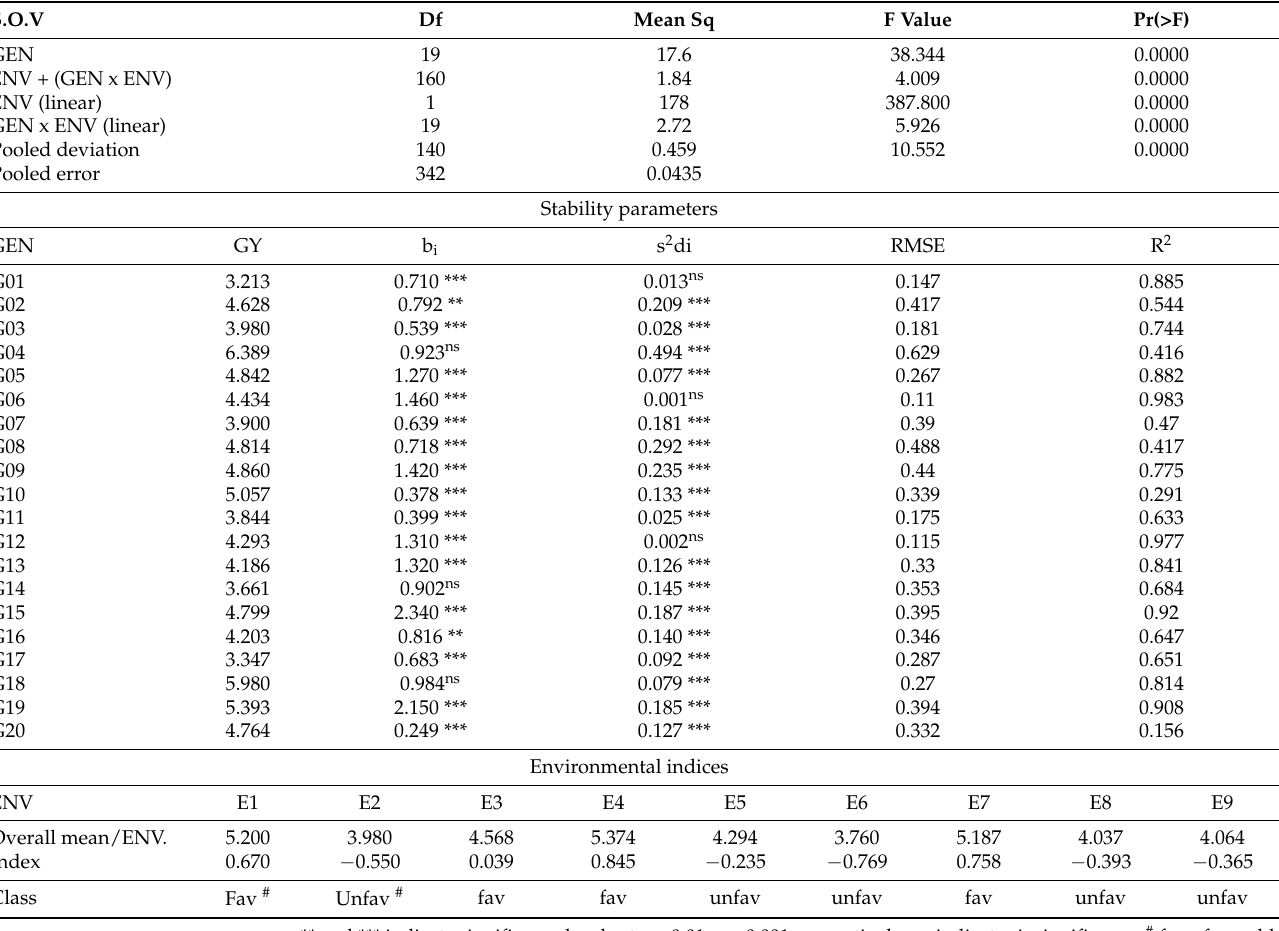
Table 6. Pooled analysis of variance of the 20 wheat genotypes across nine environmental for the GY (Eberhart and Russell, 1966